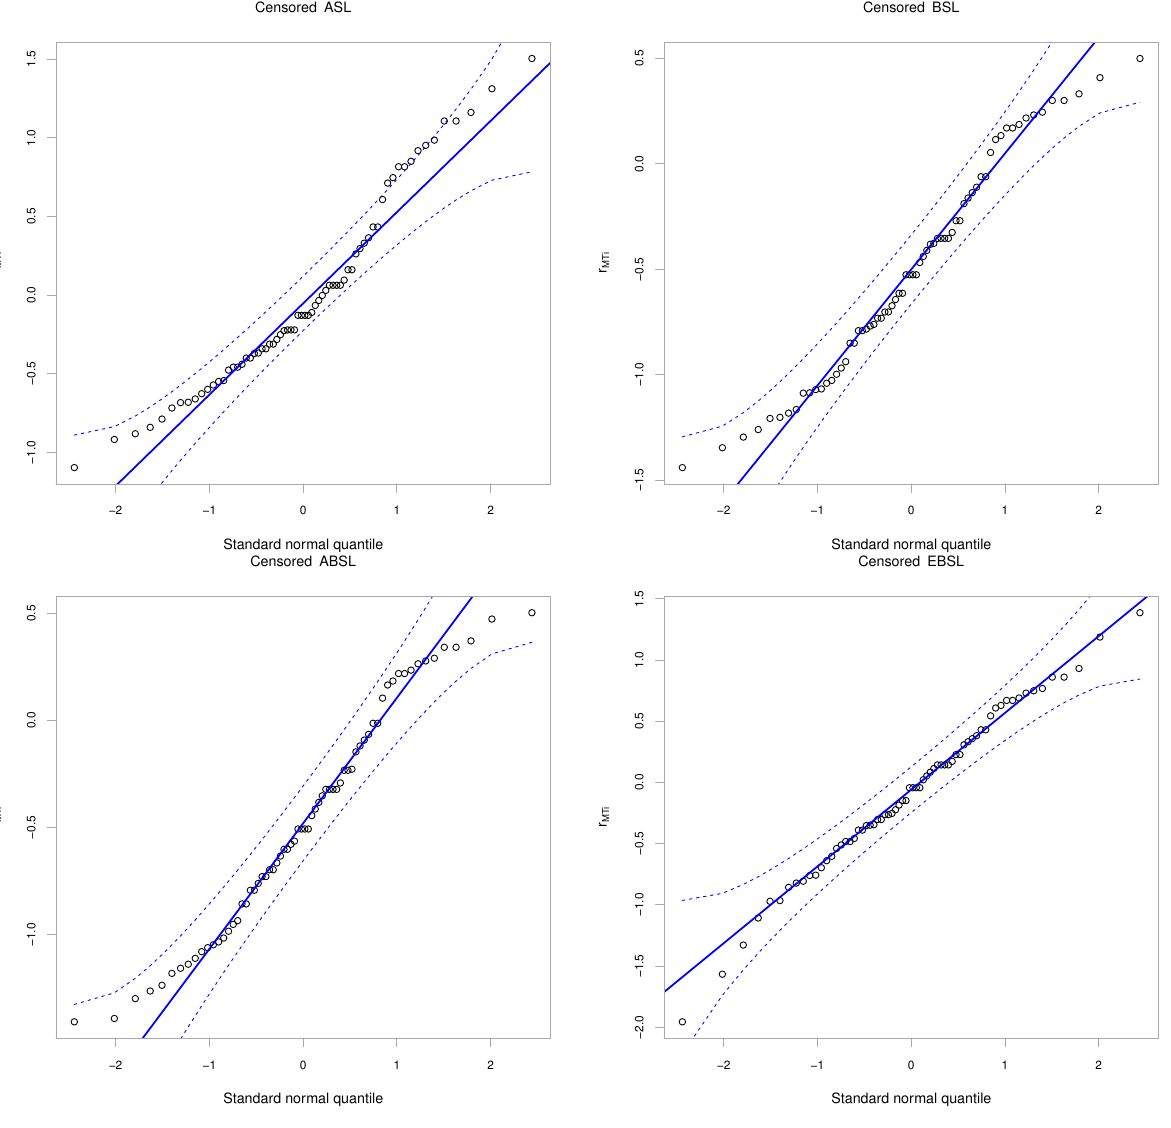
Figure 6. Stellar abundances data. Envelopes of transformed martingale residuals for CASL, CBSL, CABSL and CEBSL